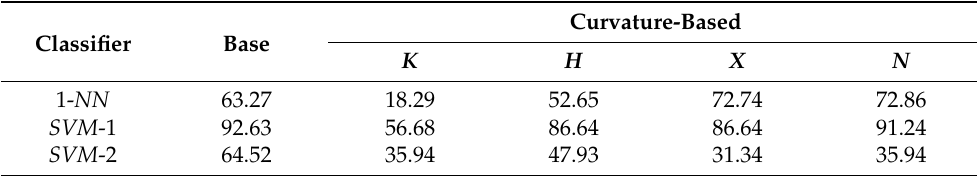
Table 7. The accuracy (%) results from the EYB dataset for the eyebrow images and the extracted